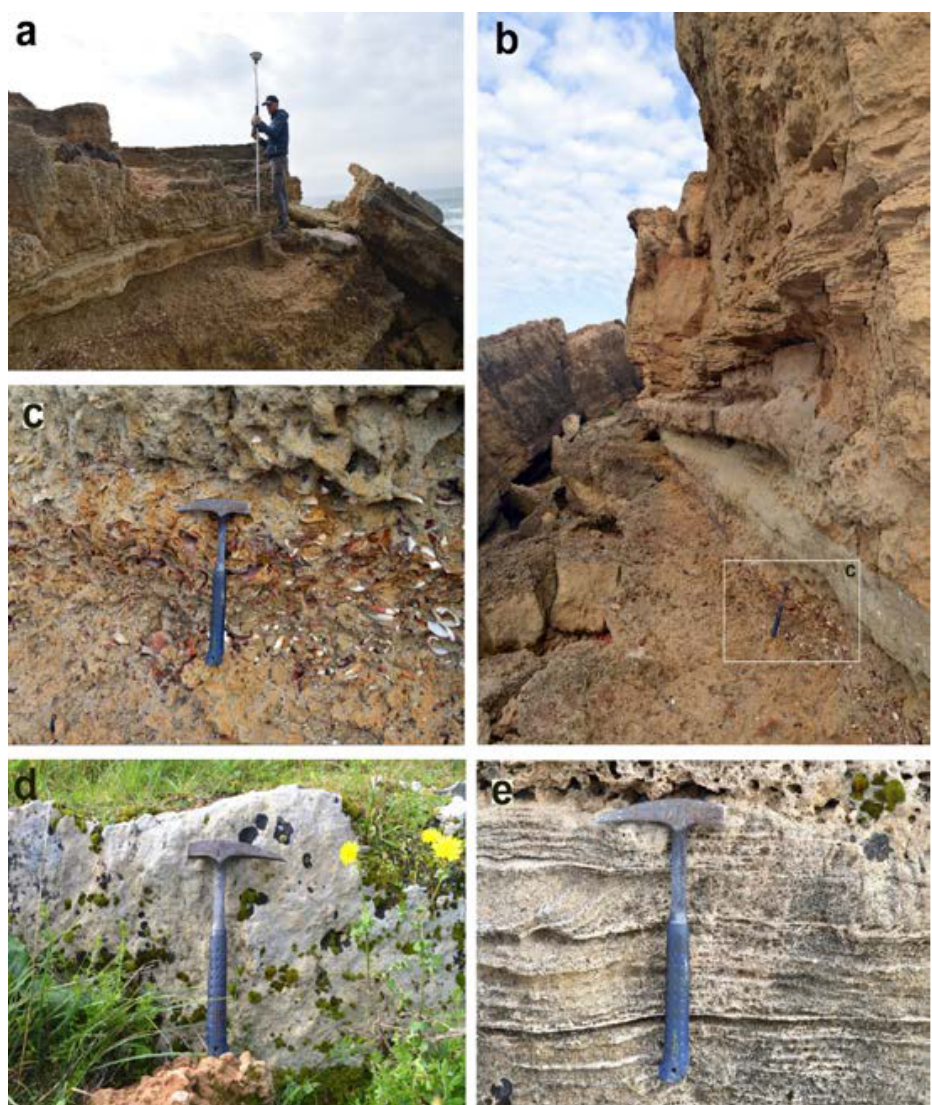
Figure 8. ( a ) DGPS measurements of the stratigraphic section of the Pleistocene deposits of San Giovanni of Sinis; ( b ) a view of the section of the San Giovanni stratigraphic showing continental deposits of the Middle Pleistocene and deposits of the last interglacial fossilized by regression aeolian sediments [8,36,37] (Figure 8); ( c ) particular of the organogenic level composed exclusively of valves of Mitilus galloprovincialis (MIS5); ( d ) excavation surface of the Phoenician-Punic quarry (2500 yrs BP) engraved in the MIS 5.5 beach sandstones in the paleo-littoral spit of Cabras; ( e ) detail showing the plane-parallel laminations that enclose a foreset